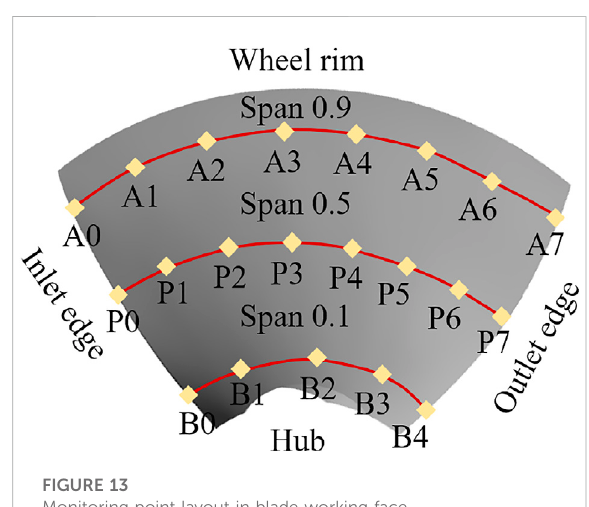
FIGURE 13 Monitoring point layout in blade working